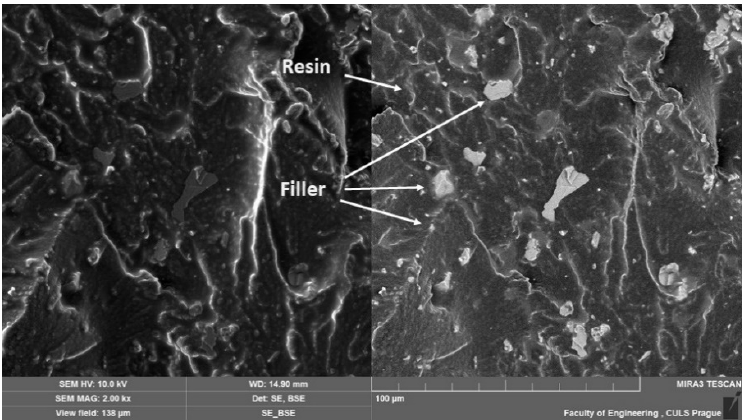
Figure 13. SEM images of fracture surface with filler CaCO 3 calcium carbonate, mixing speed—1170 rpm (MAG 2.00 k×). SE figure is shown on the left and the BSE on the right.